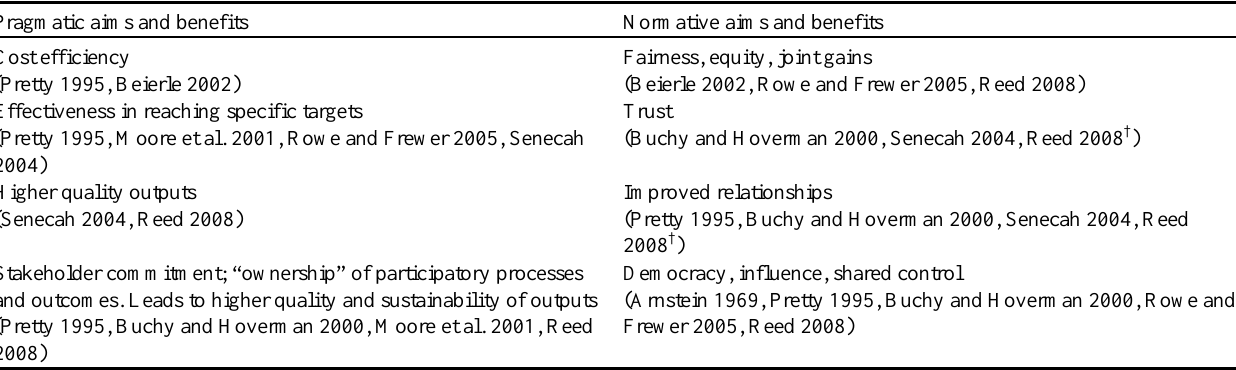
Table 1 . Frequently mentioned aims and benefits with